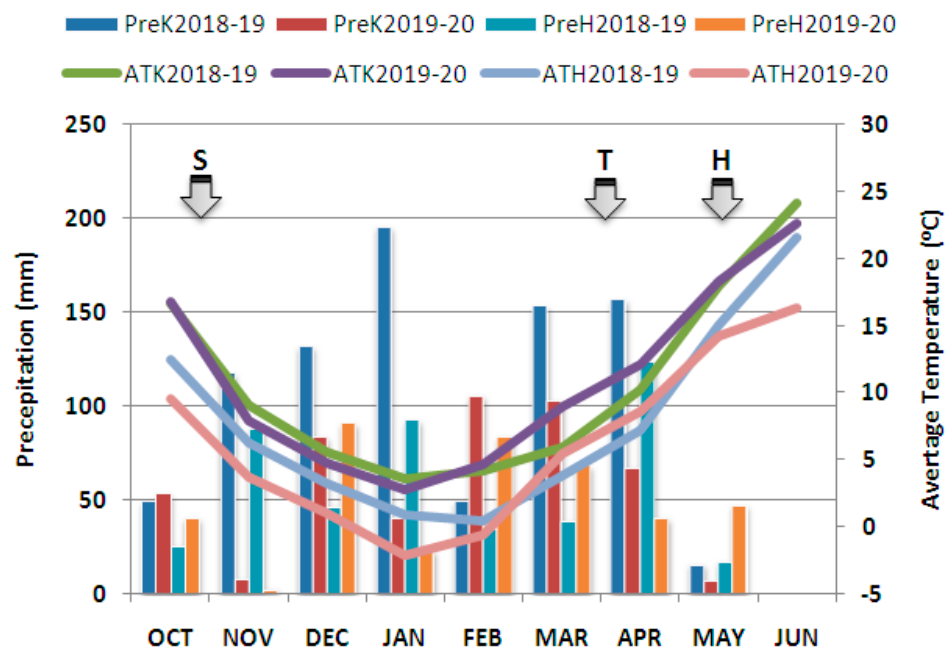
Figure 1. Monthly rainfall distribution and average temperature during the experiments. PreK: pre- cipitation at Kamyaran: PreH: precipitation at Hosseinabad; ATK: average temperature at Kamyaran; and AVH: average temperature at Hosseinabad; S: sowing; T: tillering; H: heading date.